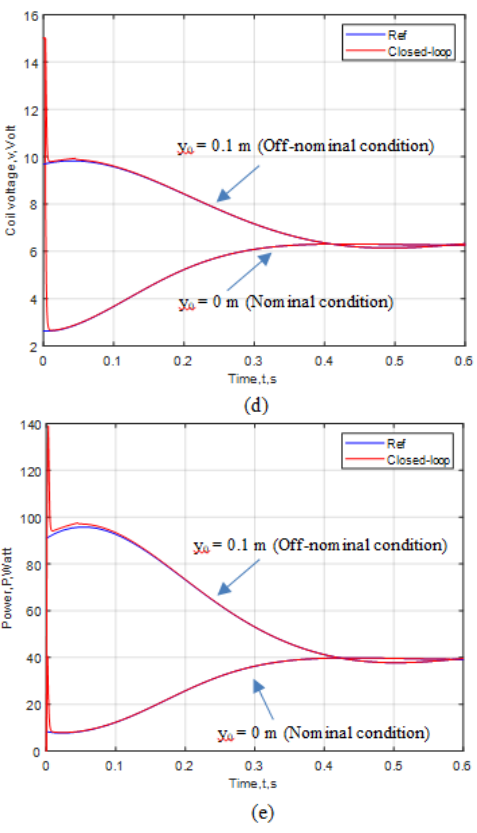
Figure 6. Reference and actual profiles for nominal (y 0 = 0 m) and off-nominal (y 0 = 0.1 m) conditions, respectively; (a) ball position vs. time; (b) ball velocity vs. time; (c) coil current vs. time; (e) voltage current vs. time; (f) electrical power vs. time.